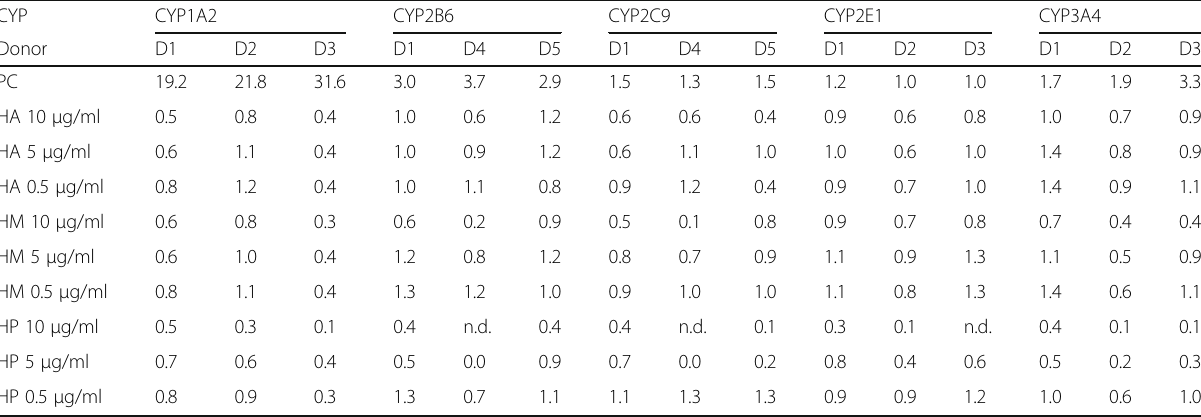
Table 2 Induction of different cytochrome P450 isoenzymes in cultured human hepatocytes from five different donors with Helixor® A (HA), Helixor® M (HM) and Helixor® P (HP). Fold induction of activity over respective negative control (incubation with no test item) is given. Test mixtures containing reference inducers were used as positive controls